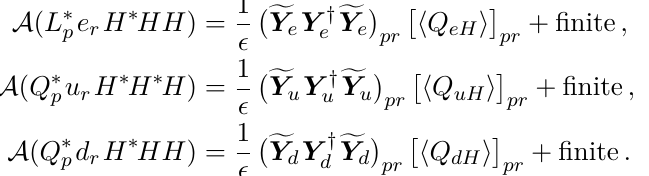
and e Y , such as u d